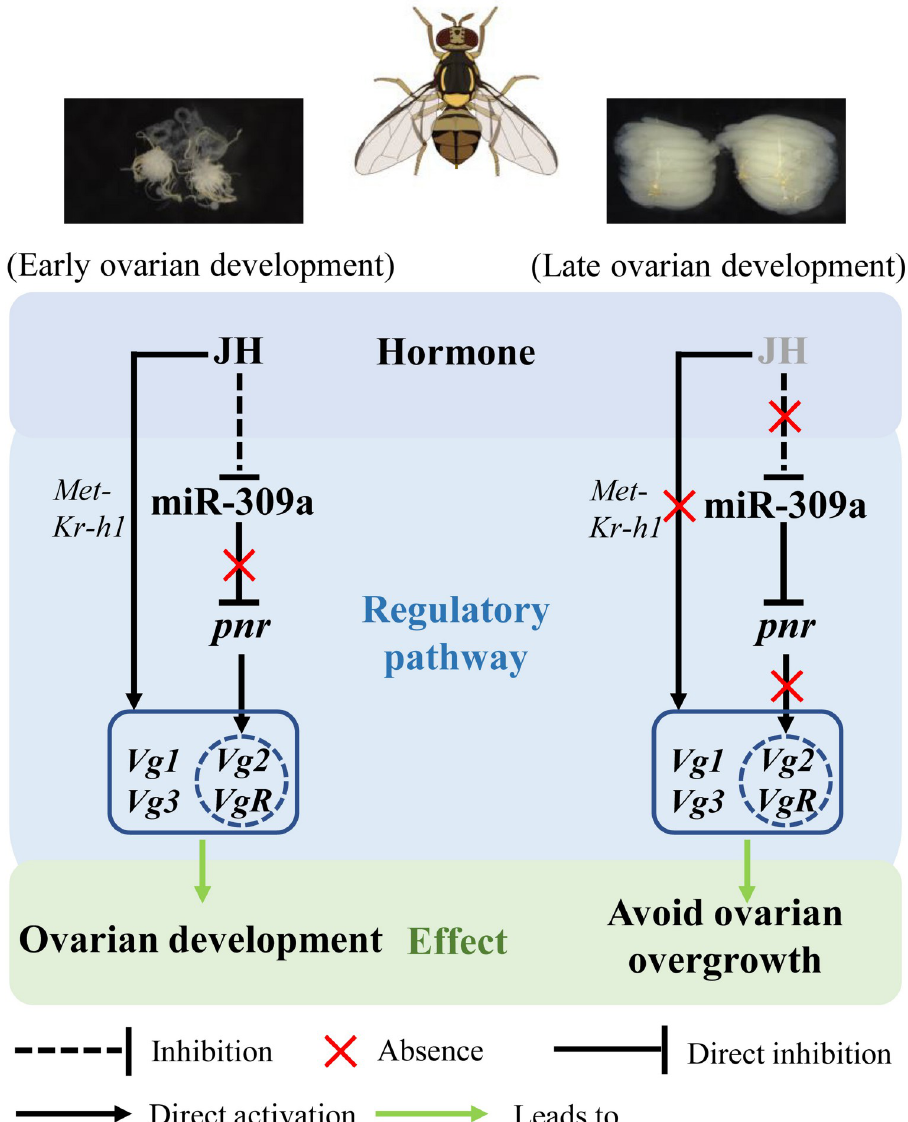
Fig 9. Mechanism of miR-309a in the regulation of ovarian development in B . dorsalis . During early ovarian development, miR-309a has lowered expression due to JH suppression and cannot inhibit pnr expression. At this stage, pnr induces the expression of Vg -related genes in ovarian development to maintain normal physiological activities. With the reduction of JH inhibition, miR-309a up-regulates and inhibits the expression of pnr to avoid excessive expression of Vg -related genes ( Vg2 and VgR ). JH may act as the upstream switch of the miR-309a regulatory pathway to maintain the balance and stability of the whole pathway by inhibiting miR-309a expression.